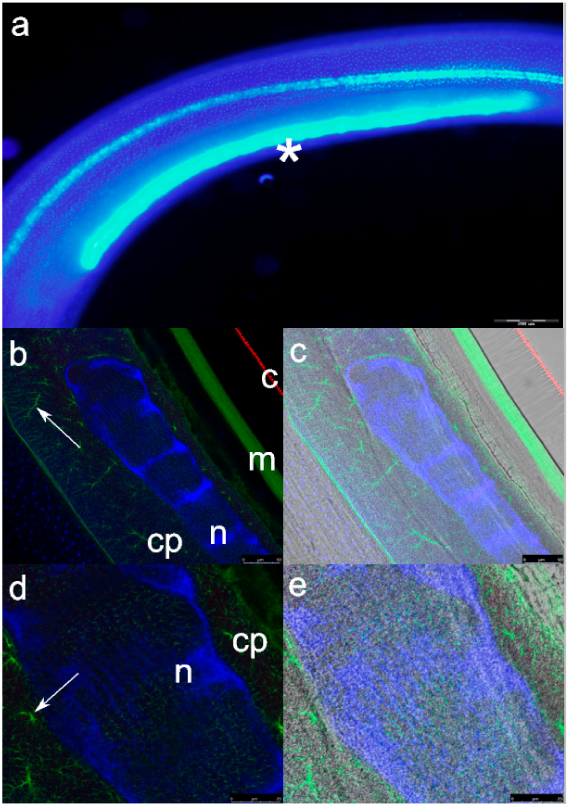
Figure 1. Immunohistochemical localization of β -tubulin (red, labeled by monoclonal antitubulin-Cy3 antibody), actin (green, labeled by Atto 488 phalloidin), and excretory cell nucleus (blue, labeled by 4,6-diamidino-2-phenylindole [DAPI]) in Anisakis pegre ffi i third-stage larvae: ( a ) whole-mounted specimen showing long, rod-like excretory cell nucleus (*); ( b ) excretory cell nucleus (n), cytoplasm (cp), somatic muscles (m), and cuticle (c). Arrow points to canaliculi in the excretory cell cytoplasm; ( c ) same as under ( b ) after merging of the specimen under the bright field and immunofluorescence; ( d ) higher magnification of the excretory cell nucleus (n), cytoplasm (cp), and canaliculi (arrow). Note mesh-like localization of the DAPI signal in the nucleus; ( e ) same as under ( d ) after merging of the specimen under the bright field and immunofluorescence. Scale bars: ( a ) 200 µ m; ( b ) and ( c ) 50 µ m; ( d ), and ( e ) 25 µ